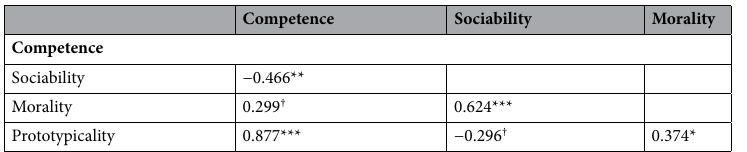
Table 1. Correlations between social evaluations and prototypicality. Correlations with prototypicality did not include generic occupations of “scientist” and “researcher”. † p < 0.10, * p < 0.05, ** p < 0.01, *** p <